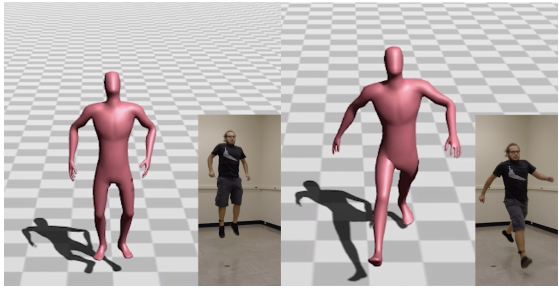
Figure 9. Hopping and jumping poses reconstructed with the proposed